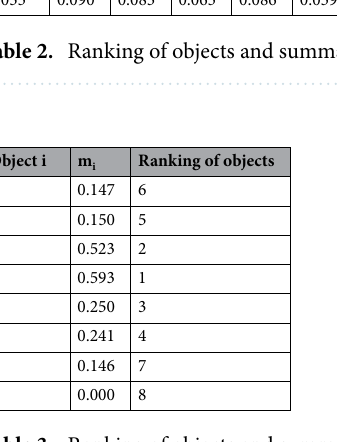
Table 3. Ranking of objects and summary of development measure values.